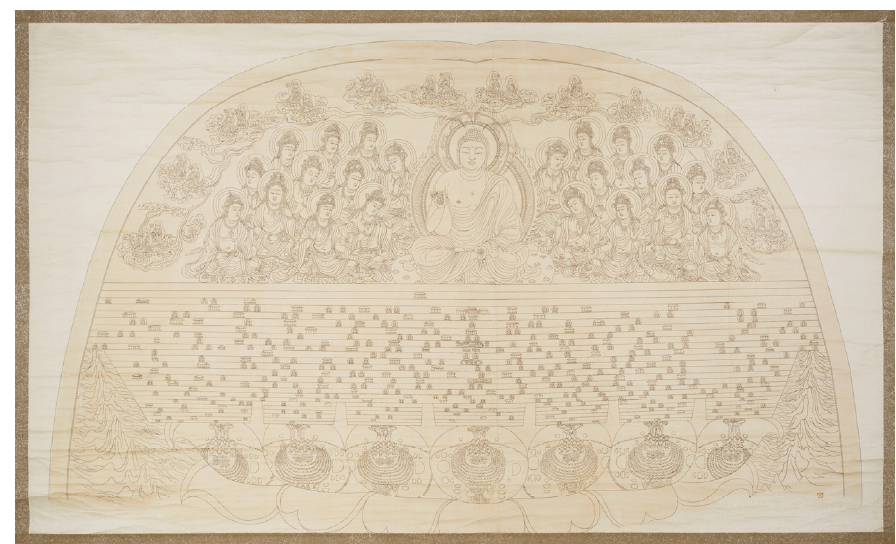
Figure 5. Lotus-Treasury World . Copy of the line carving on the bronze pedestal. Seated Vairocana Buddha. Tōdaiji, Nara prefecture. Original: Nara period, mid 8th century. In the collection of Nara National Museum. Image: Nara National Museum.